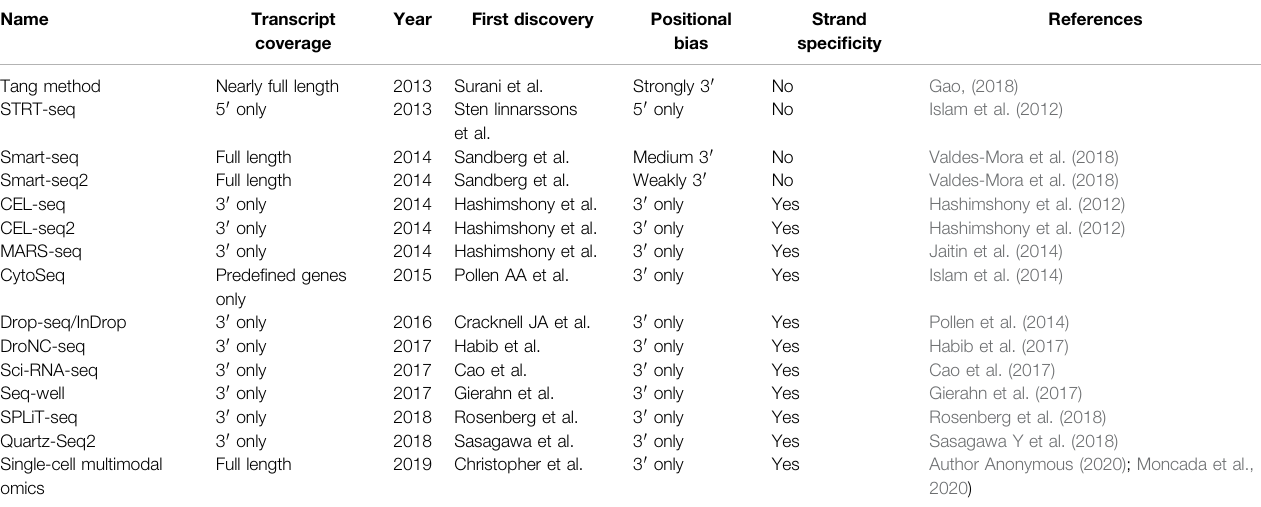
TABLE 1 | Principal characteristics of the most widely used scRNA-seq methods.